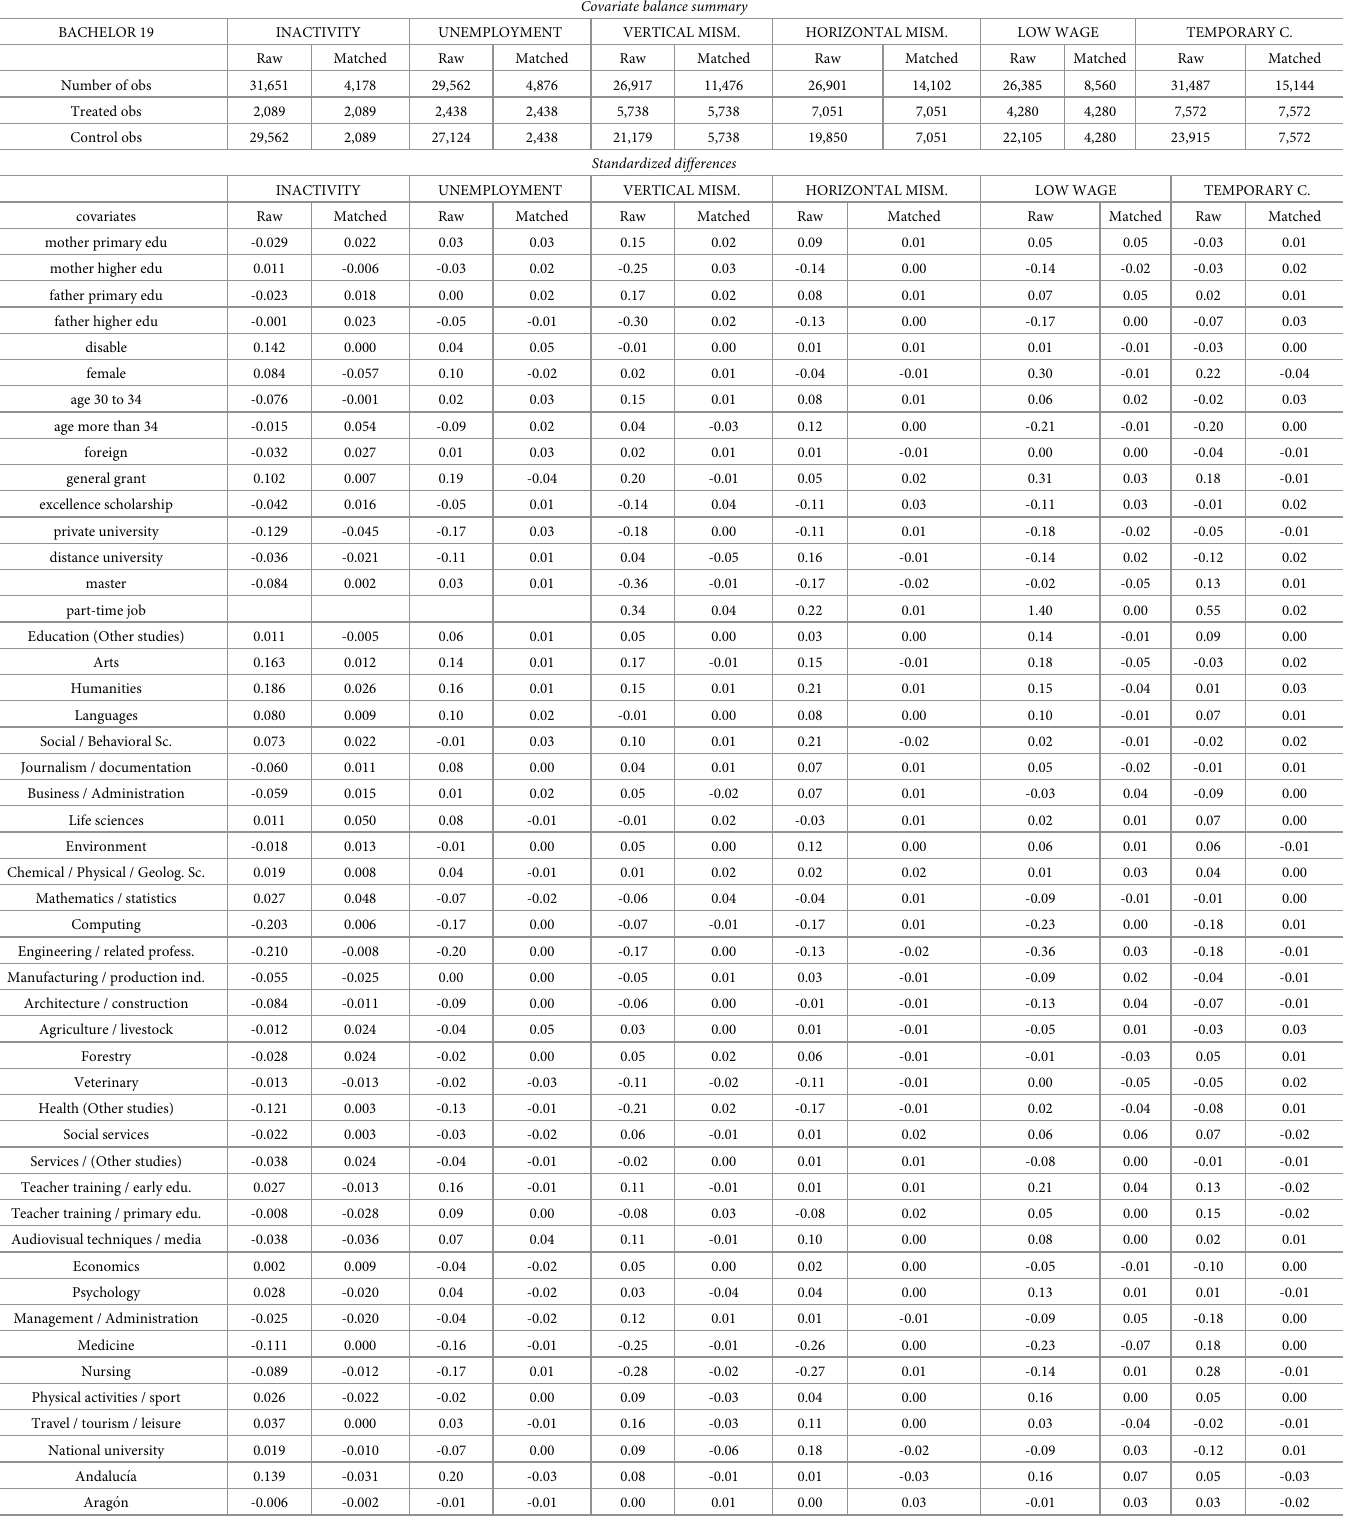
Table 4. Standardized mean differences before and after matching (Bachelor 2019). Covariatebalancesummary BACHELOR19 INACTIVITY UNEMPLOYMENT VERTICALMISM. HORIZONTALMISM. LOWWAGE TEMPORARYC.